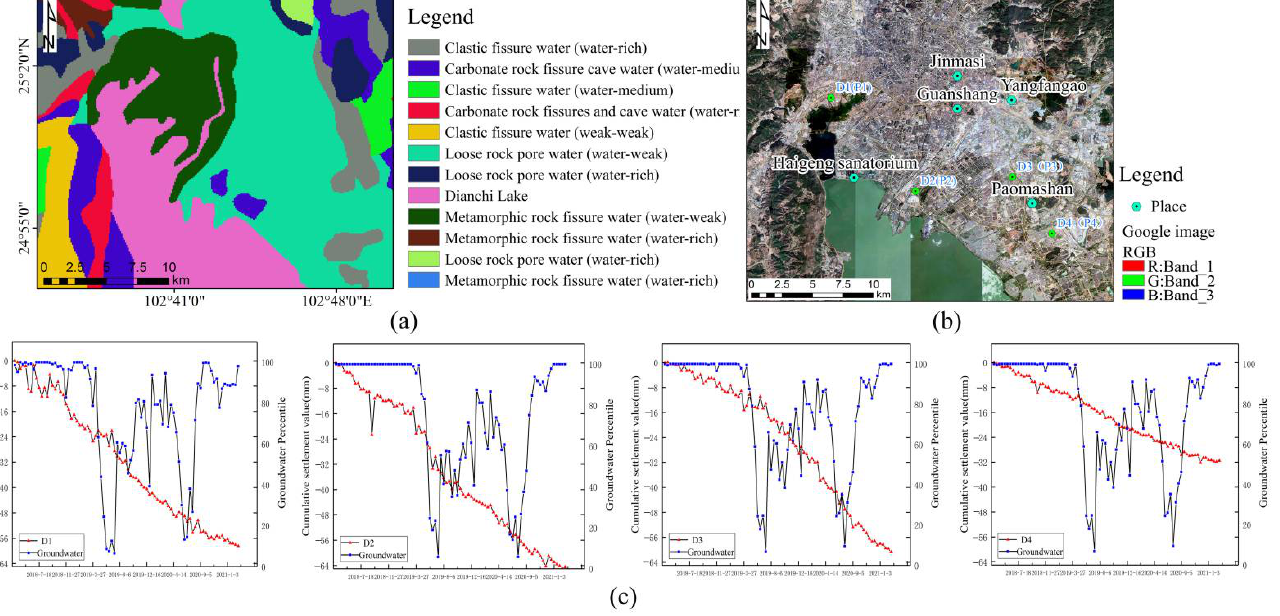
Figure 12. Correlation analysis diagram of hydrogeology to surface deformation: ( a ) is a vector diagram of hydrogeology in the study area; ( b ) is the name of groundwater exploitation in the corresponding block (the corresponding data are superimposed on a Google image; randomly selected relative timing point locations D1, D2, D3, D4 and P1, P2, P3, P4 were superimposed on Google images). The analysis results are shown in ( c ).